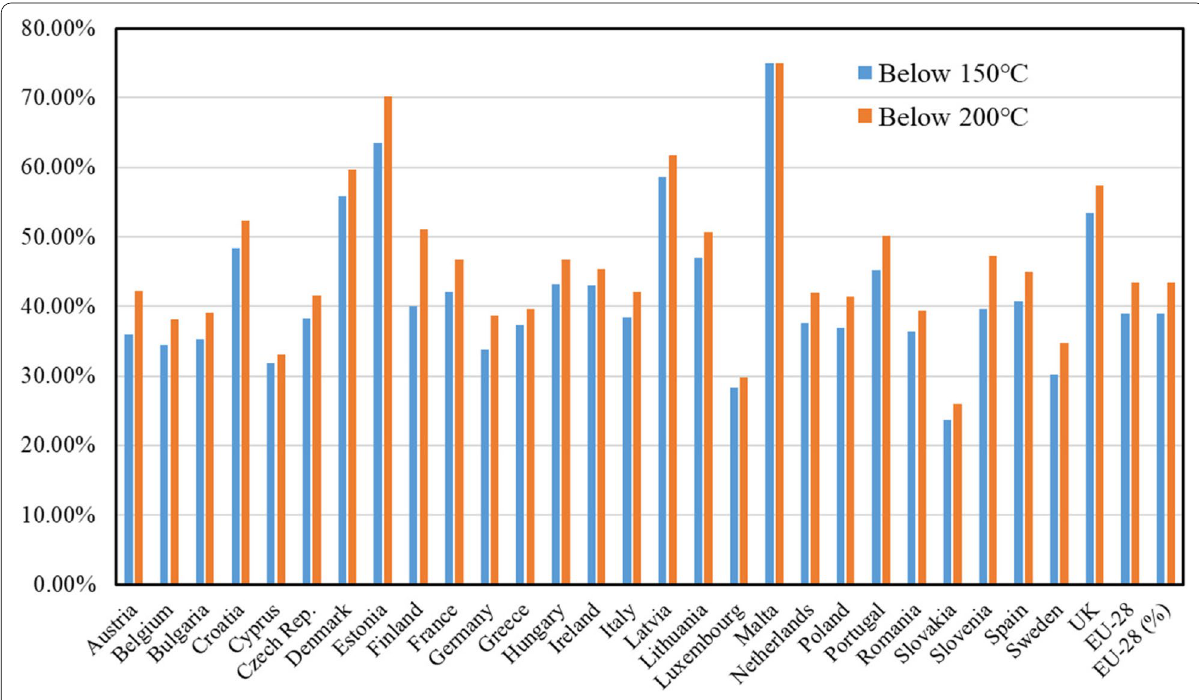
Fig. 7 Heating energy consumption fractions in EU industries divided by temperature [57]